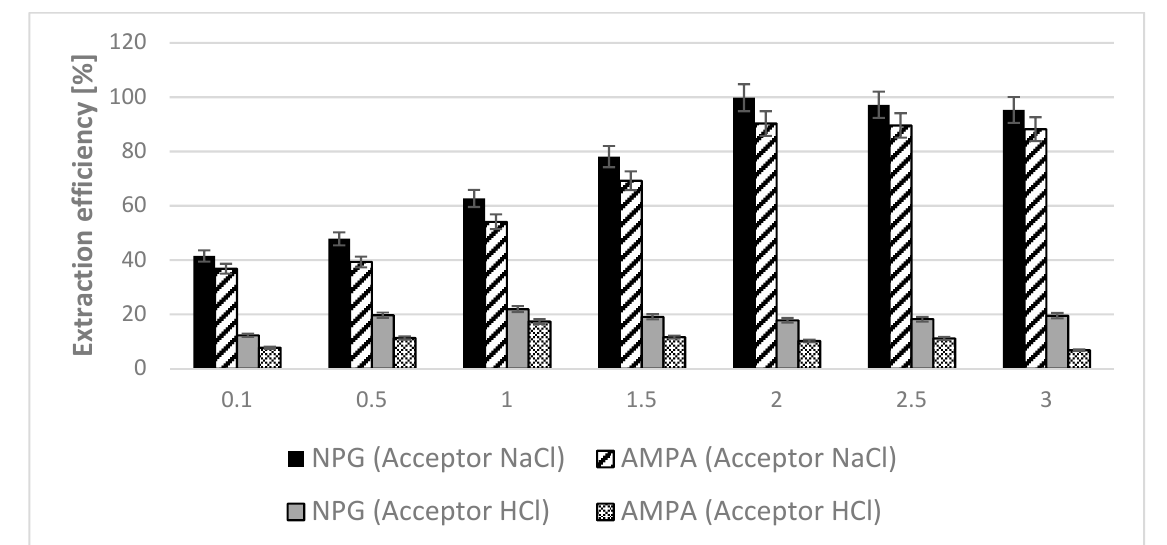
Figure 1. Influence of the type and concentrations of acceptor phase on the SLM extraction efficiency of tested analytes from aqueous samples. (SLM conditions—donor phase: an aqueous solution of NPG and AMPA mixture at a concentration of 0.6 mg L − 1 and pH 11 (sample volume 100 mL); acceptor phase: NaCl or HCl solutions; membrane phase: 20% Aliquat 336 in DHE; the flow rate of the donor and acceptor phase 0.2 mL min − 1 ; extraction time—24 h).